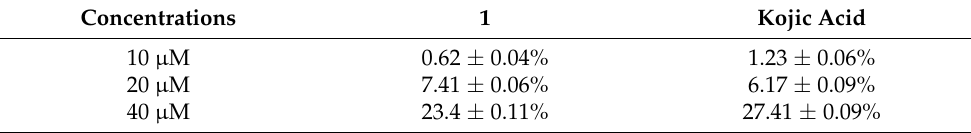
Table 2. Tyrosinase inhibition rate (%) of compound 1 at different concentrations ( µ M).